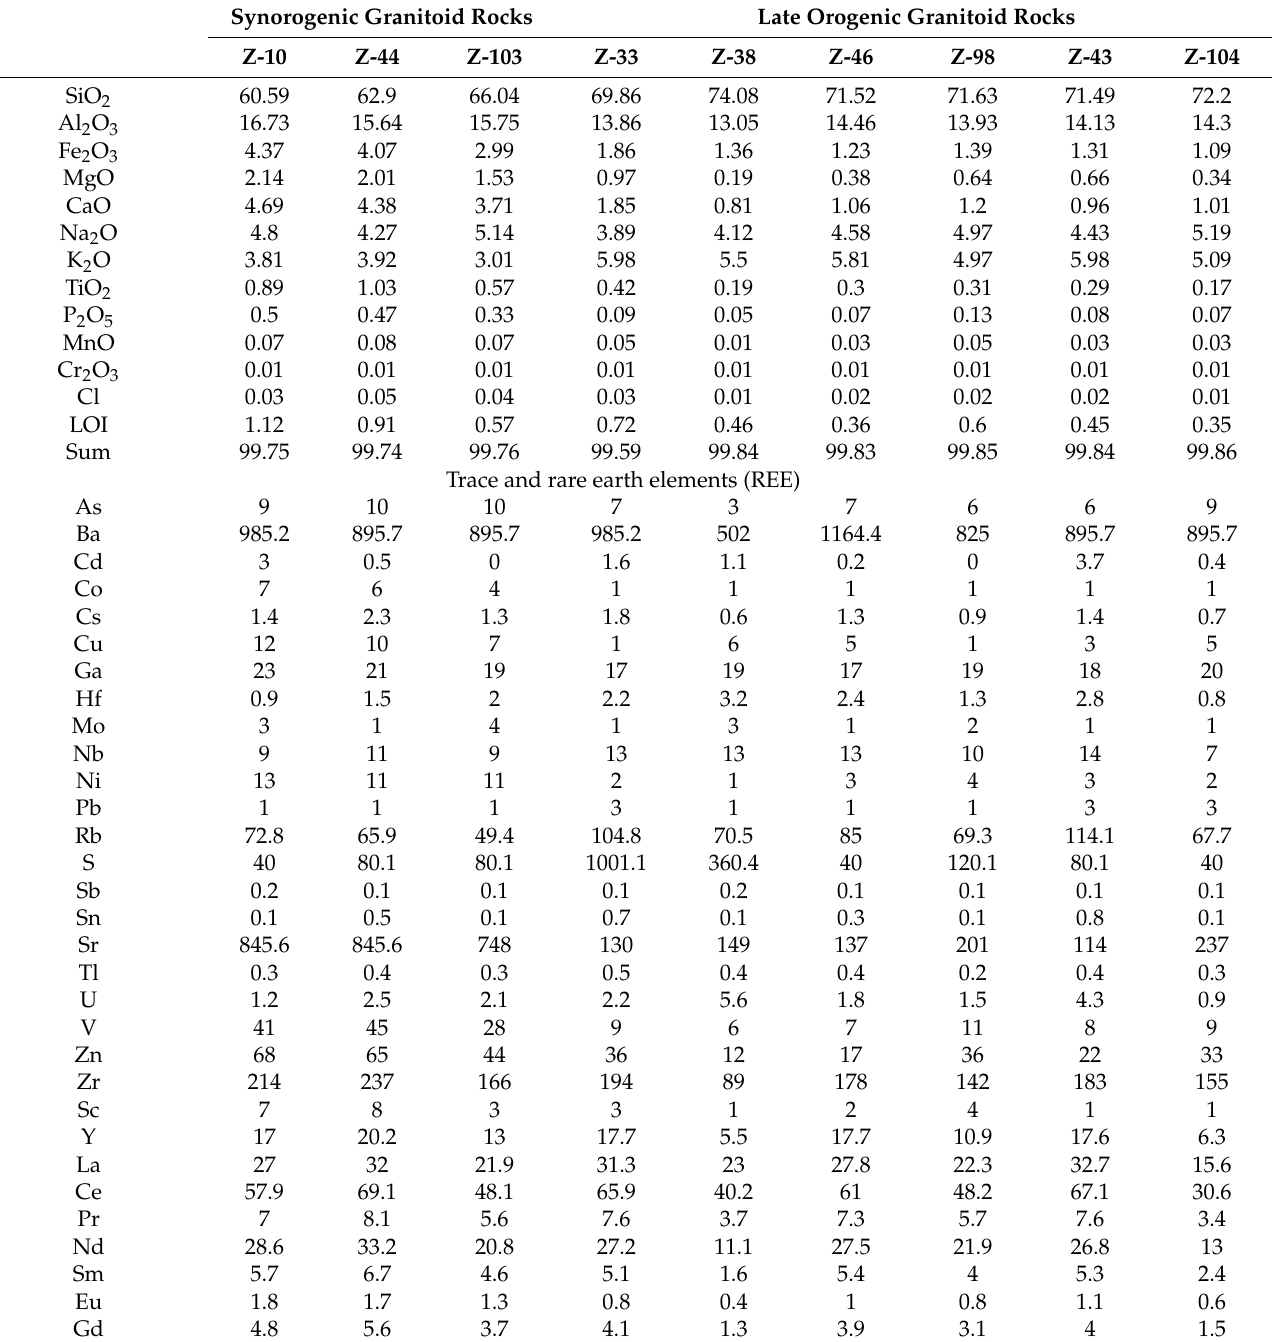
Table 3. Major oxides, trace and REE data of the synorogenic and late orogenic granitoids of the Abu Zawal (Fatira) area. Synorogenic Granitoid